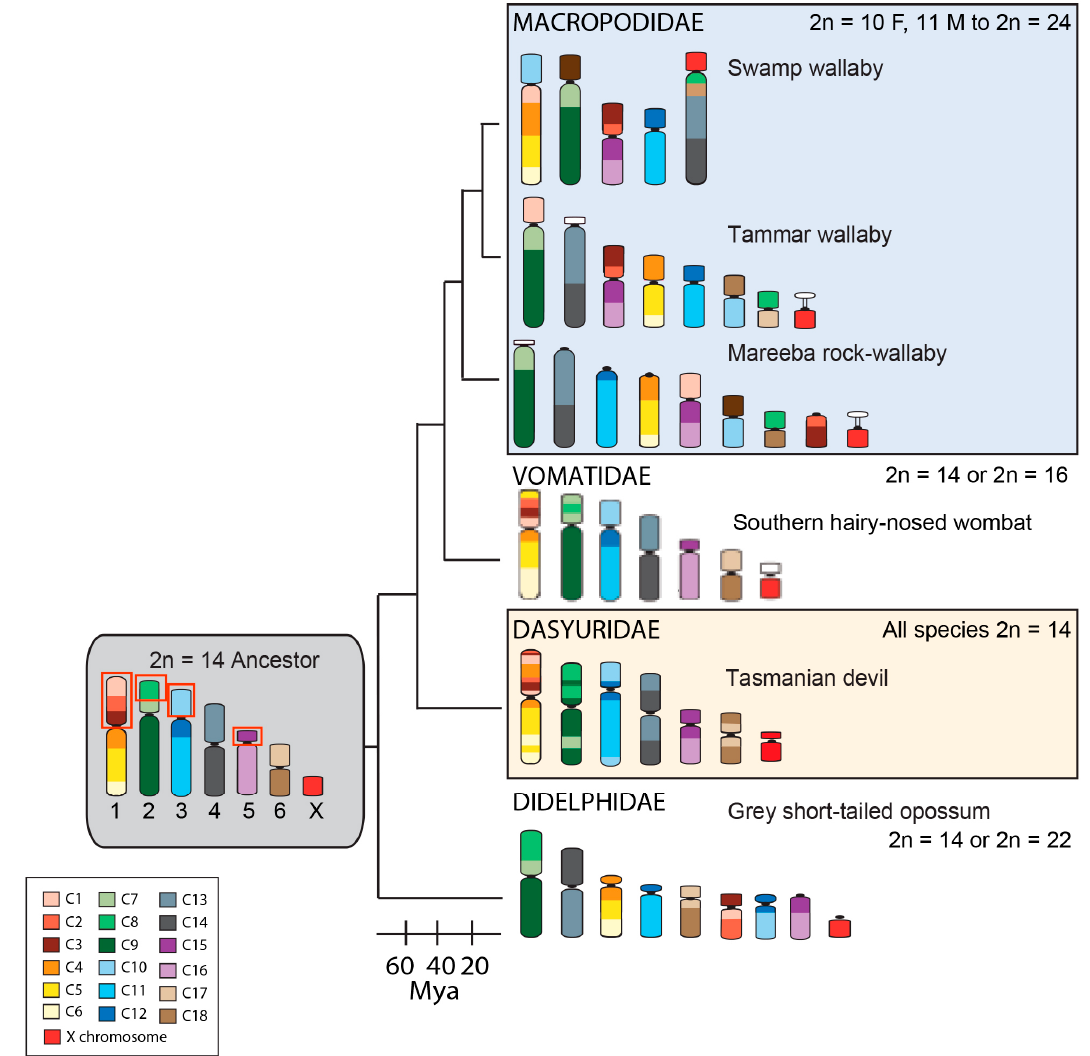
Figure 2. Arrangement of the conserved segments (C1–C19) identified in the ancestral marsupial and in species from different marsupial families. The diploid number range is indicated for each family. Chromosomes are color-coded to show the arrangement of the 19 conserved segments identified by chromosome painting [20]. The conserved segments most commonly rearranged across the marsupial phylogeny are indicated by red boxes on the ancestral karyotype. Mya—Millions of years ago.